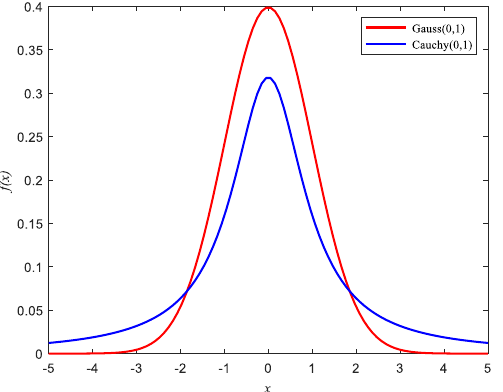
Figure 4. Probability density-curve image.